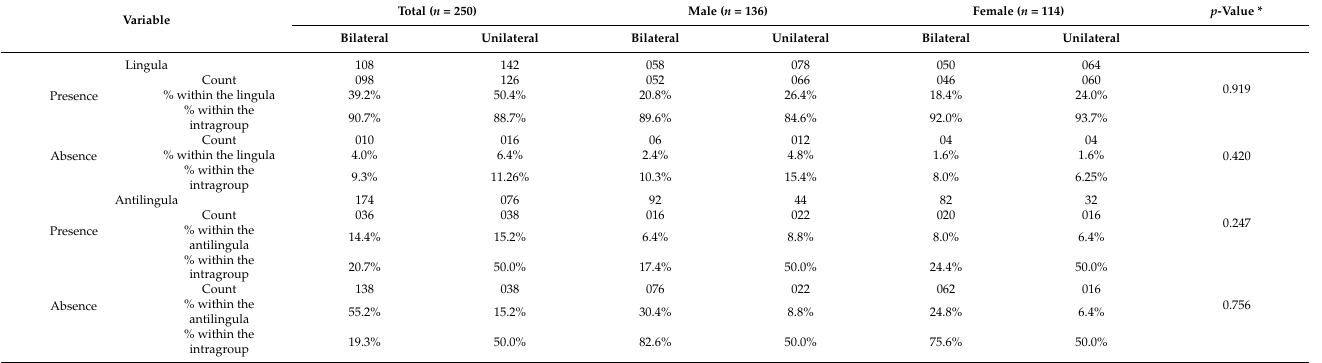
Table 5. Presence of the lingula and antilingula by the variable of gender and mandibular